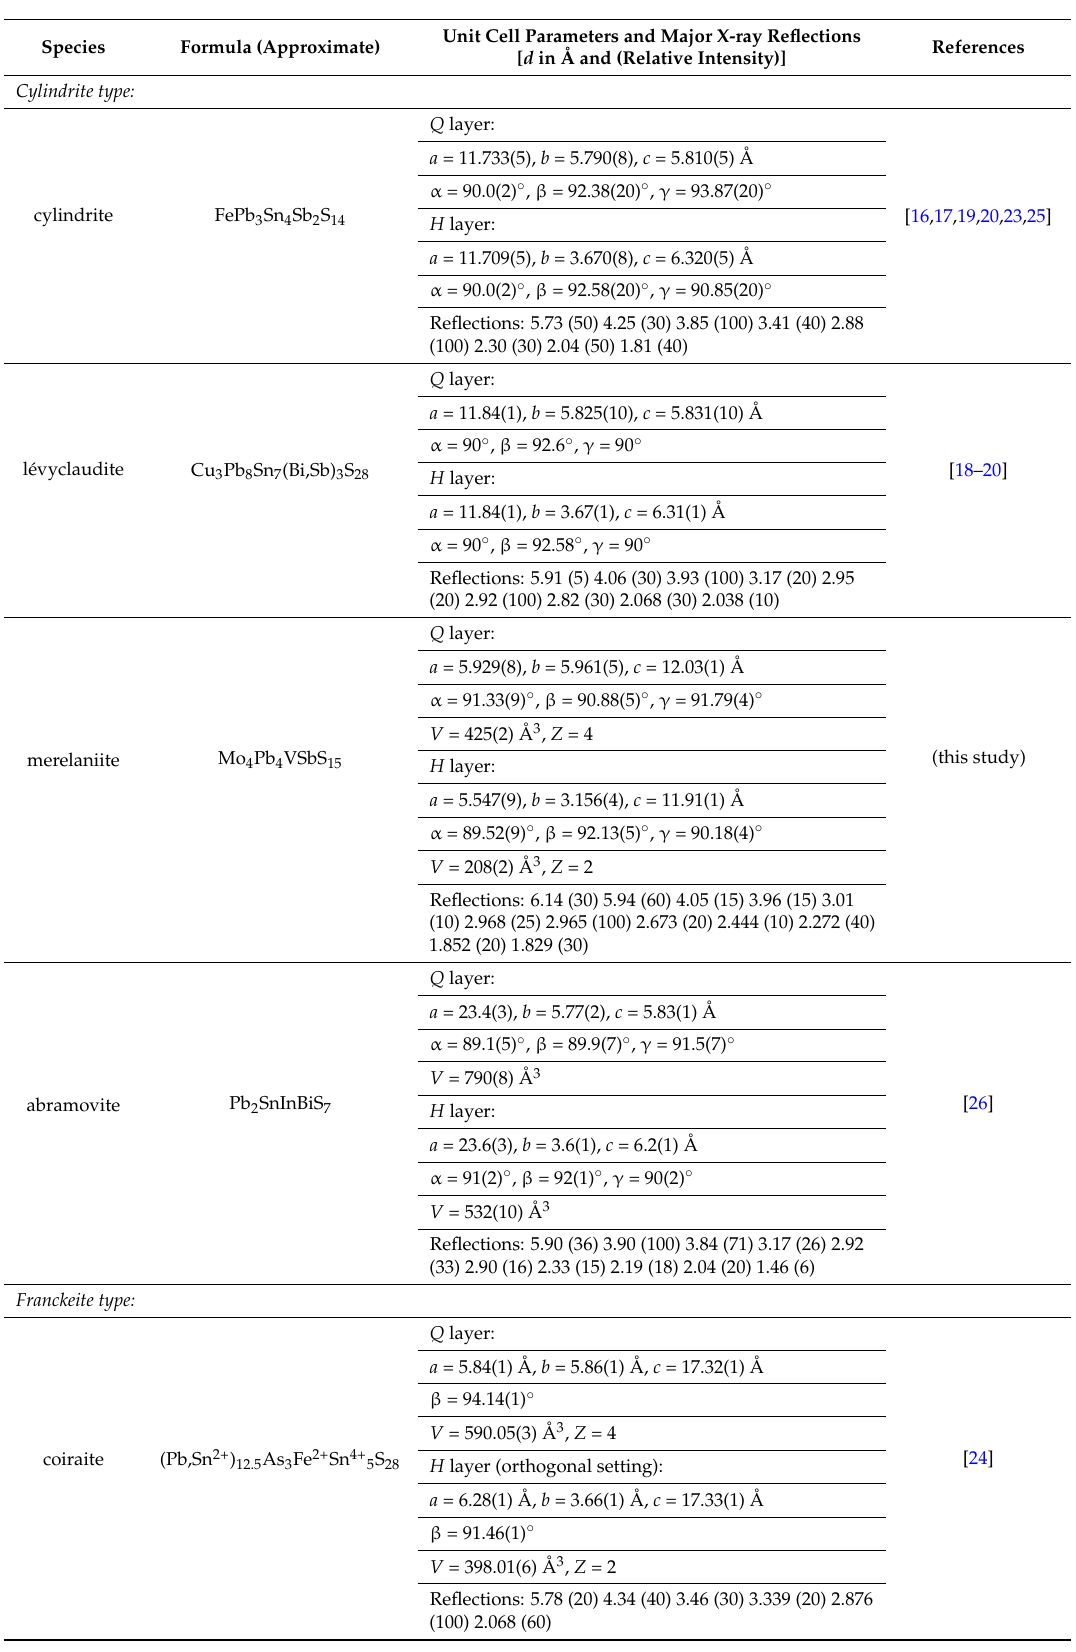
Table A1. Comparative data for minerals of the cylindrite homologous series [18,19]. (See references for details regarding the specific crystallographic setting conventions